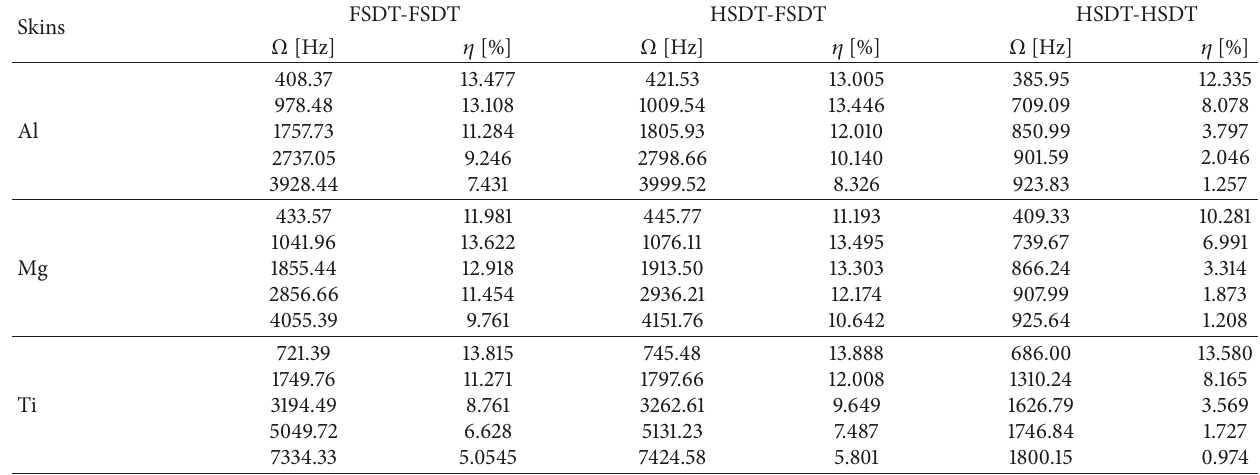
Table 9: Frequencies Ω and loss factors 𝜂 . Clamped beam.